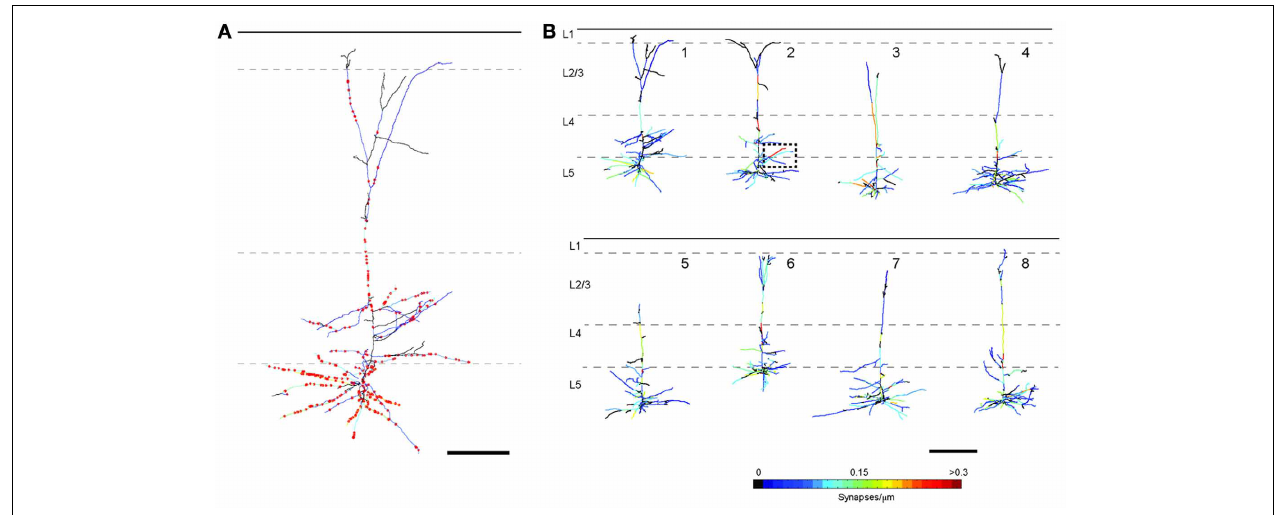
FIGURE 4 | Tracings of the eight reconstructed L5 pyramidal neurons. (A) Enlarged image of the reconstruction of neuron 1 including positions of all TC synapses (red stars; scale bar = 100 µ m). (B) Each dendritic branch is color-coded for TC synapse density (scale bar = 200 µ m).